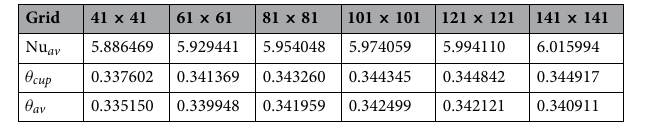
Table 3. Grid independency study at Ra = 10 5 , Da = 10 − 3 , b = 0.6, d = 0.5, Ma =